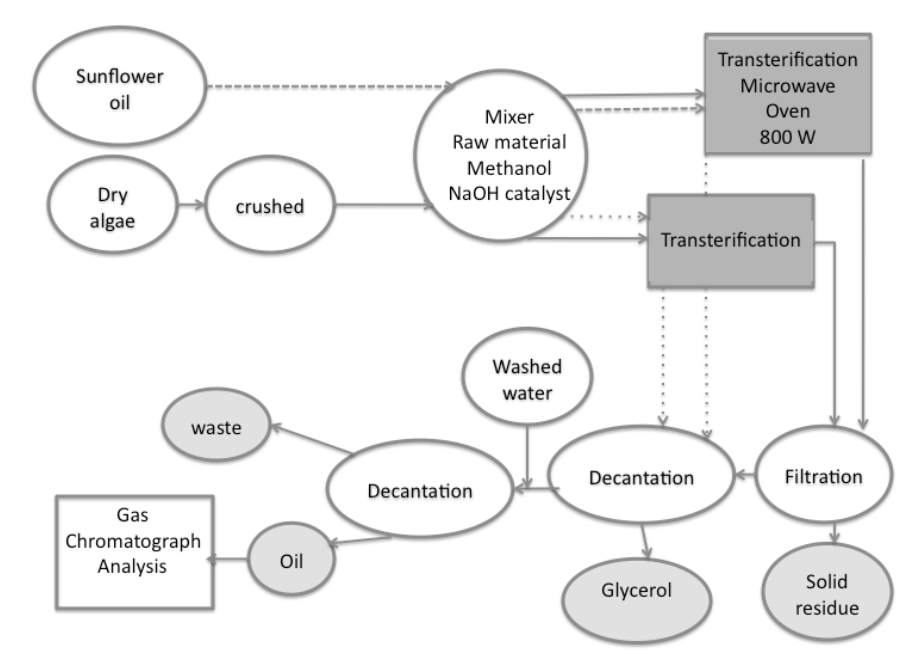
Figure 3. Schematic diagram of the